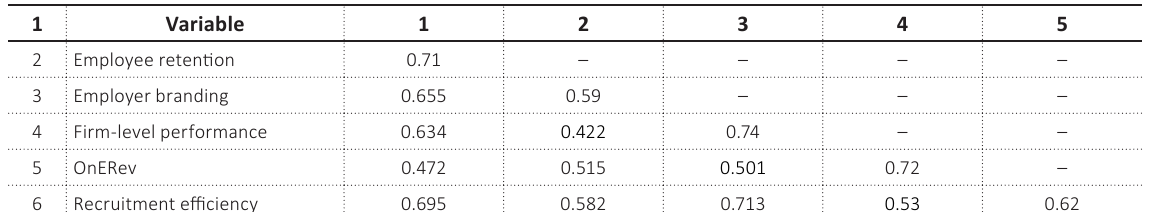
Table 3. Discriminant validity